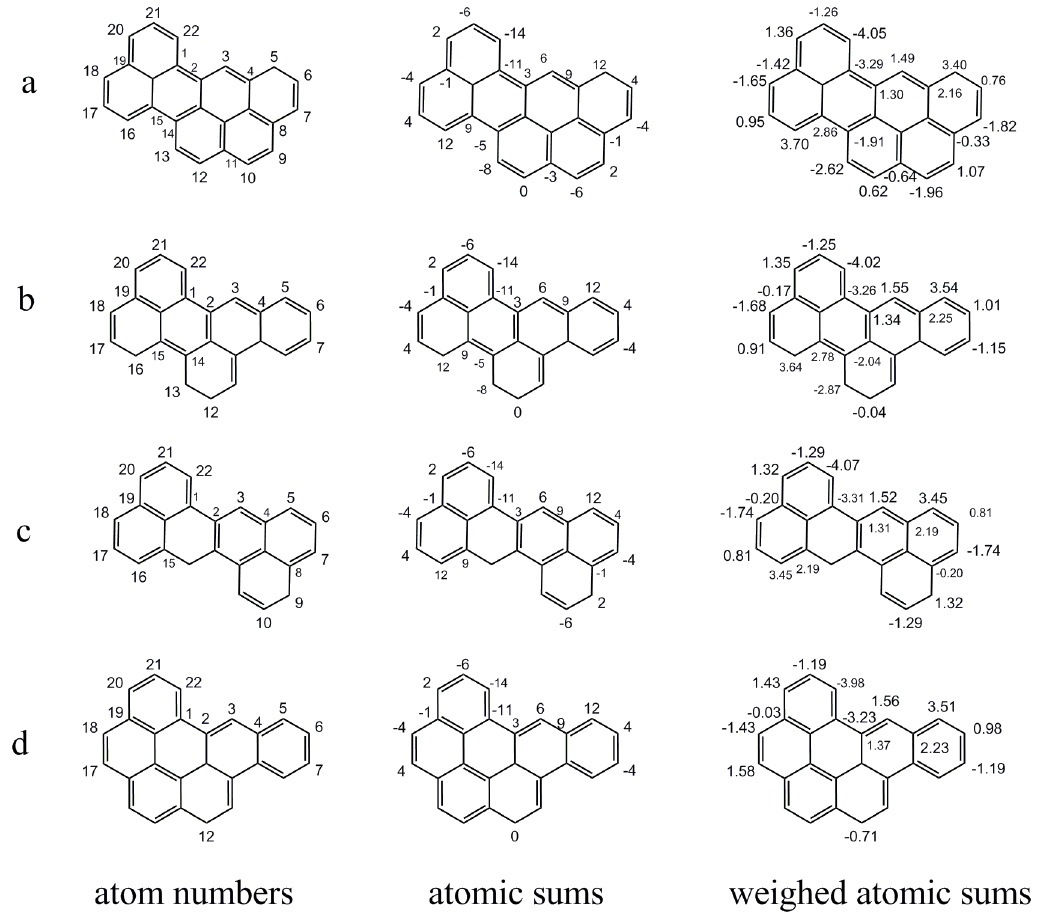
Figure 6. Comparison of sections having the same atomic sums for four benzenoids.